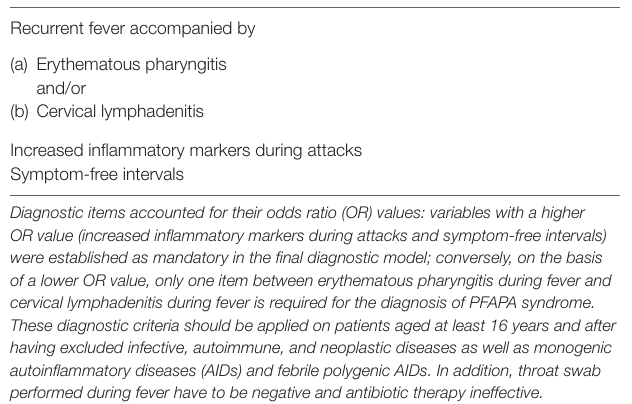
performed on adult periodic fever, aphthous stomatitis, pharyngitis, and cervical adenitis (PFAPA) patients and patients with fever of unknown origin, representing the control group.